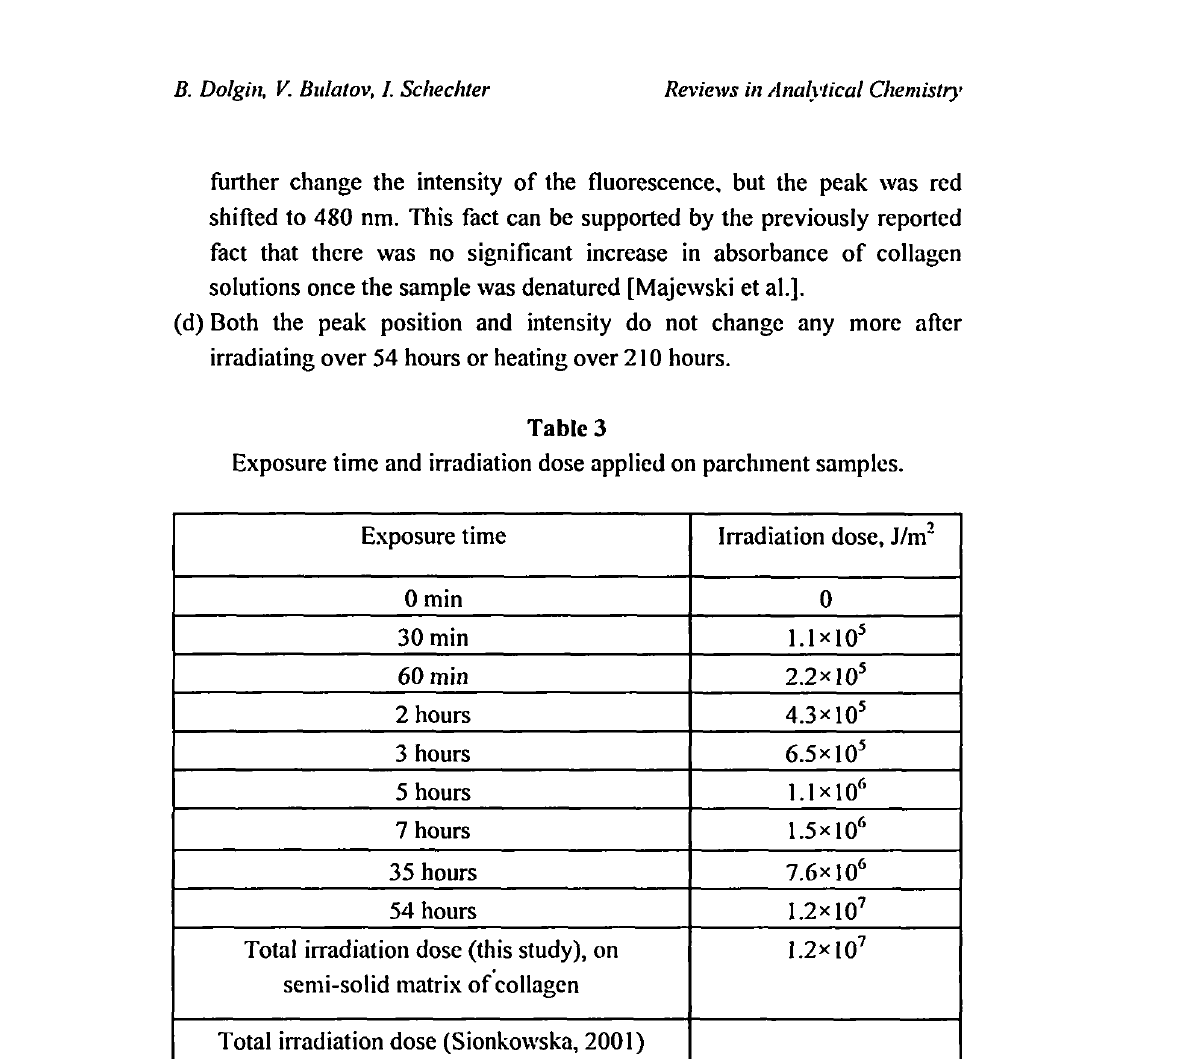
Exposure time and irradiation dose applied on parchment